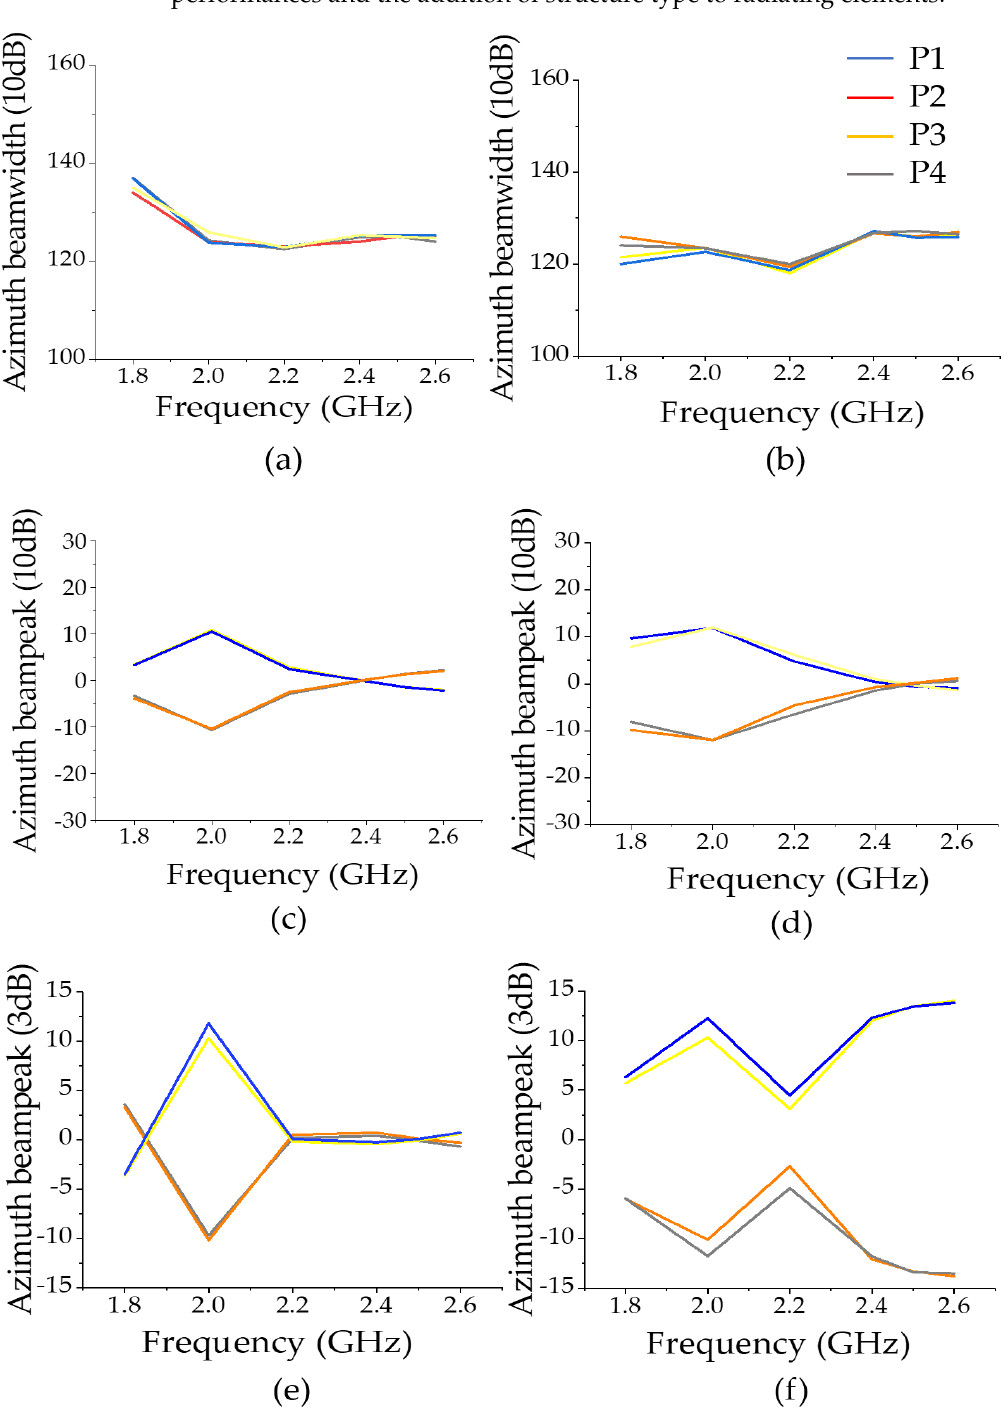
Figure 4. Measured 10 dB azimuth beamwidth of HB arrays with ( a ) LBHV element ( b ) LB slant element, 10 dB azimuth beam peak of HB arrays with ( c ) LBHV element ( d ) LB slant element, 3 dB azimuth beam peak of HB arrays with ( e ) LBHV element ( f ) LB slant element. The P1, P2, P3, and P4 refer to polarizations indicated in Figure 1. Table 2. Comparison of recent state-of-the-art works with proposed work.